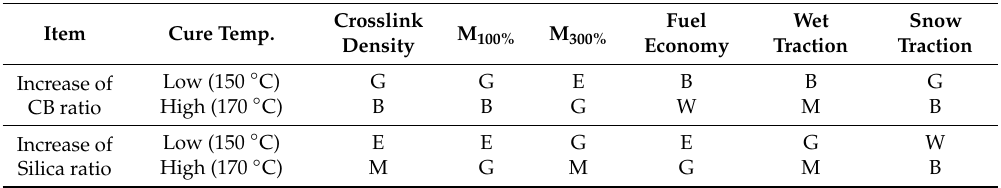
Wet Snow Traction